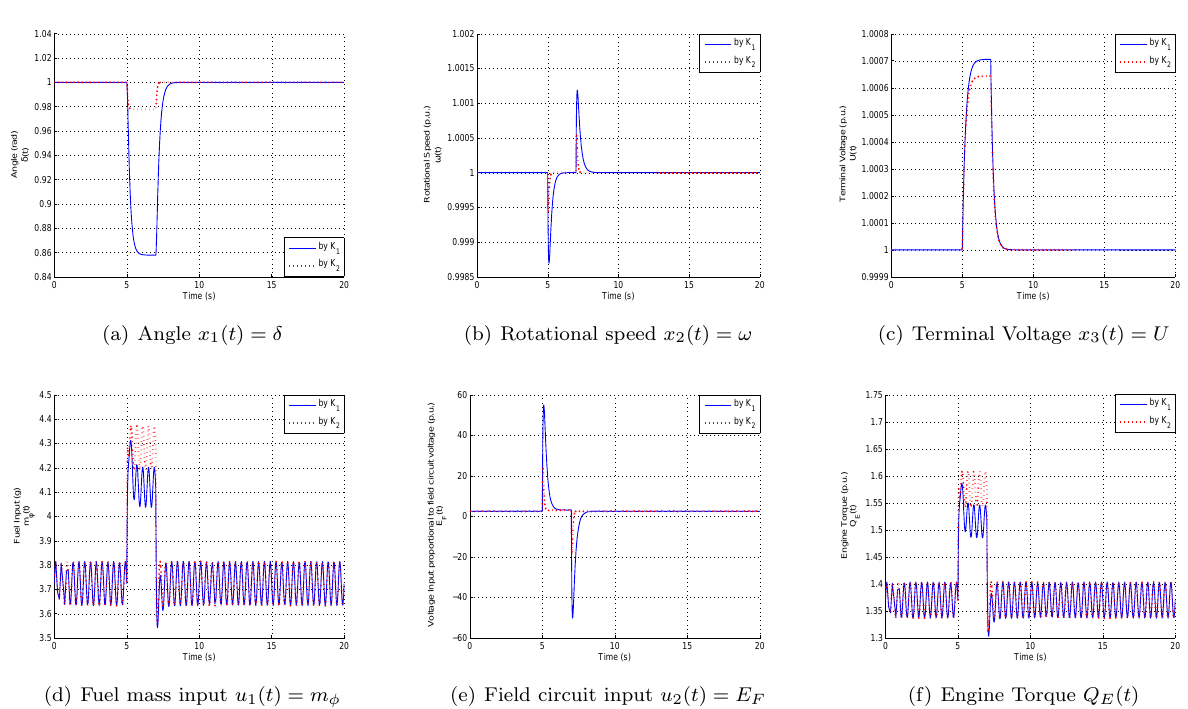
Figure 3: Results of the simulation of the model in eq.(40) with a sudden step in stator current by gains: K 1 (solid) and K 2